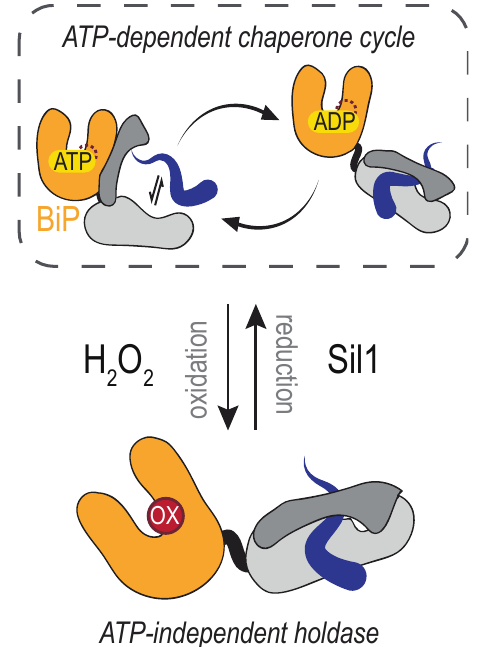
Figure 4. The Saccharomyces cerevisiae Hsp70 BiP is reversibly modified by H 2 O 2 . A conserved cysteine (red circle) in the nucleotide-binding domain (NDB, orange) of yeast BiP can be oxidized in the presence of elevated H 2 O 2 . Upon oxidation, BiP ATPase activity is inhibited yet the peptide-binding domain (grey) maintains an ability to hold polypeptides (blue). Oxidation of BiP can be reversed by Sil1, which restores the canonical Hsp70 chaperone cycle.